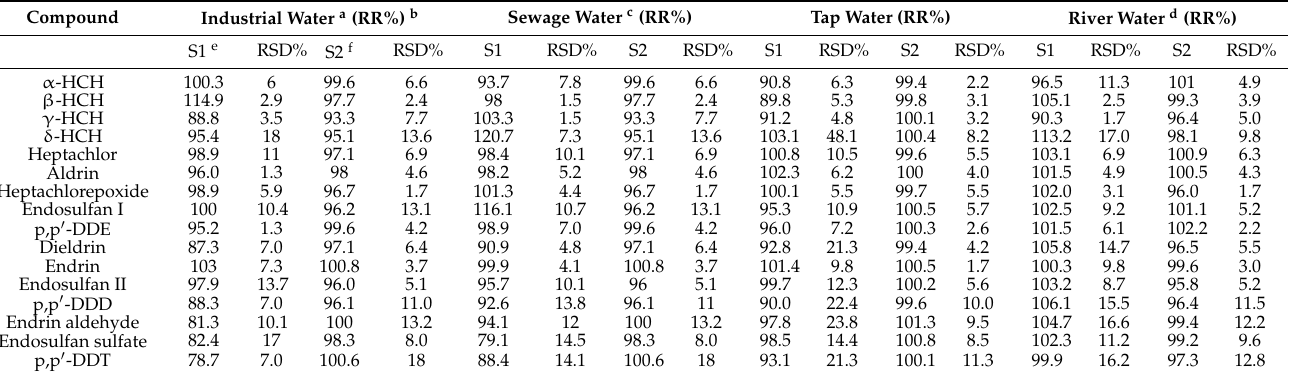
Table 2. Analytical data obtained after HS-SPME of OCPs mixture using the PET/Superhydrophobe NanoSiO 2 .